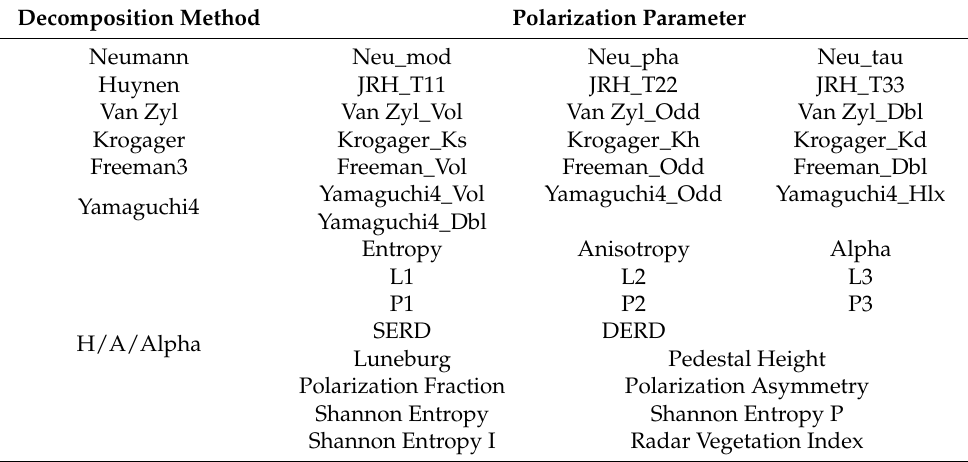
Table 3. Feature parameters extracted by different methods.